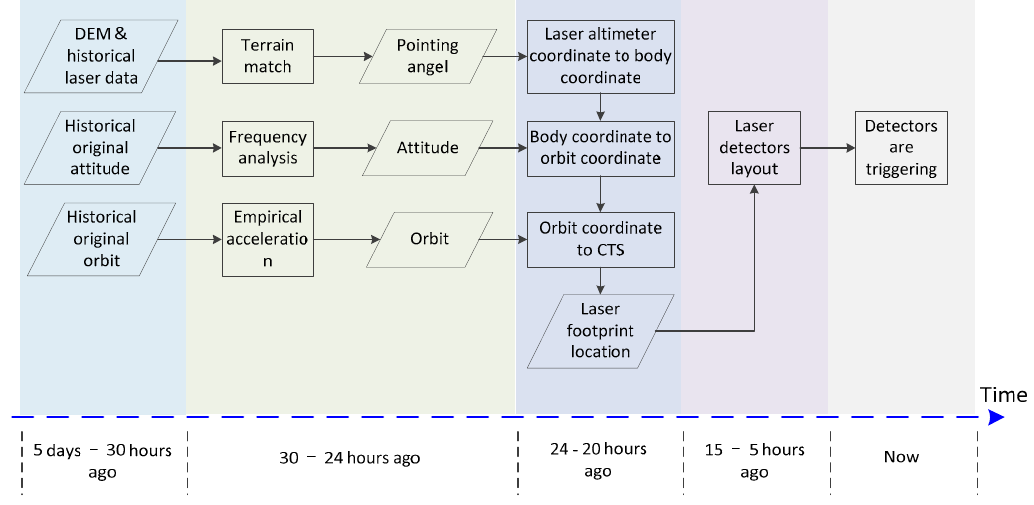
Figure 4. Workflow of laser altimeter footprint location prediction.